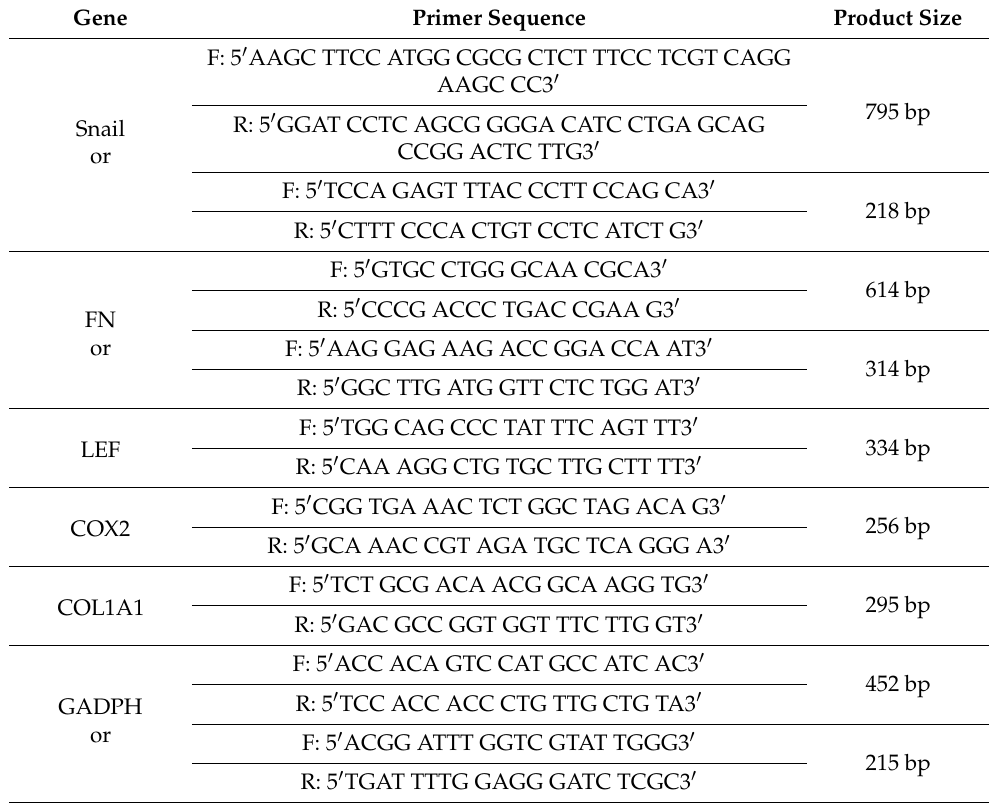
Table 2. Primers used for RT-PCR and real time PCR in gene expression